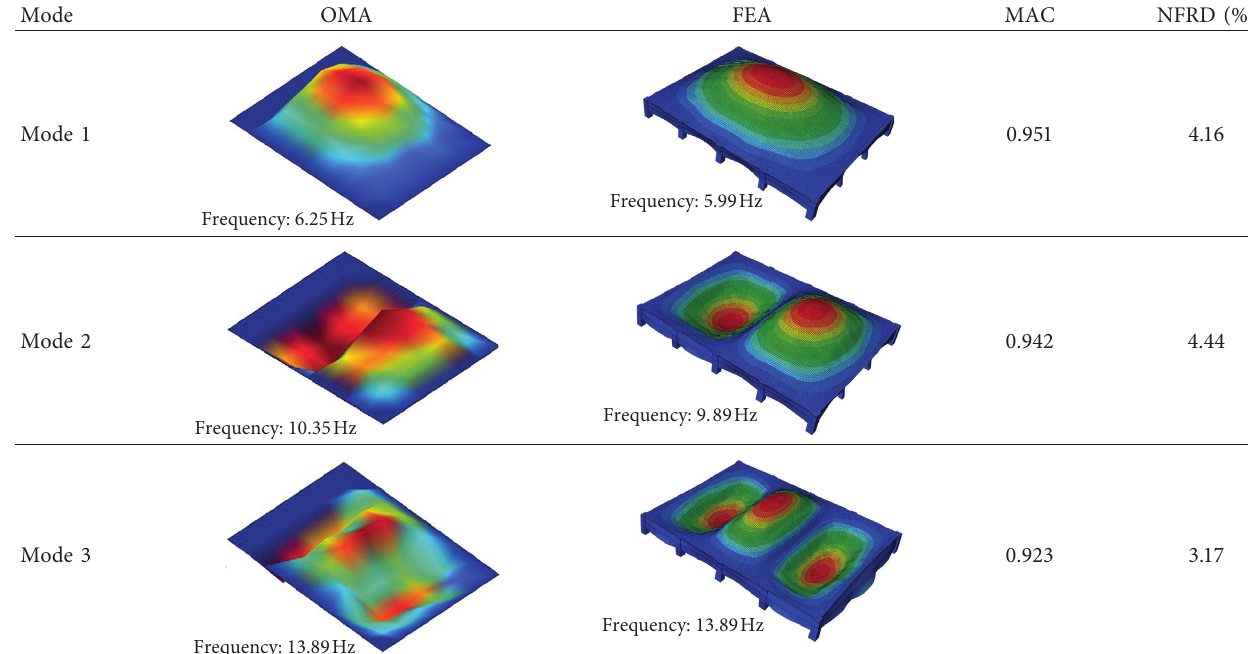
Table 1: Comparation between OMA and FEA of the CHW